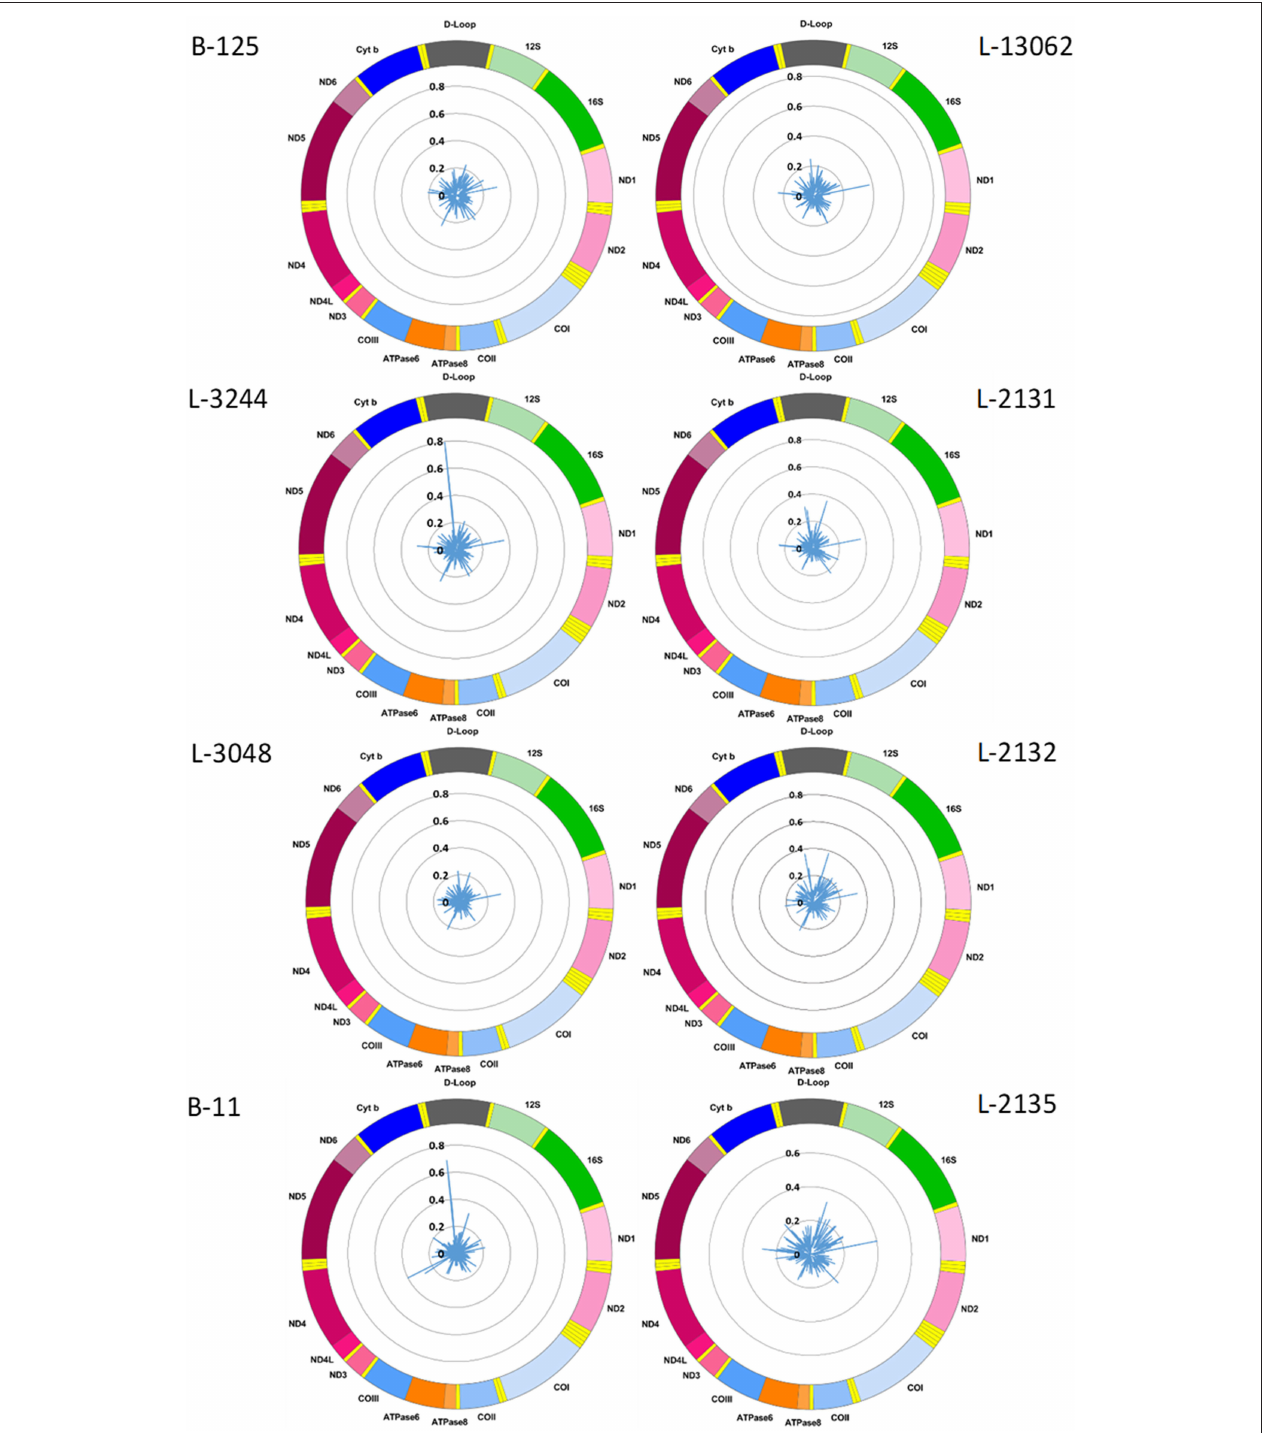
FIGURE 1 | Mitochondrial CpG methylation frequency detected by Nanopore sequencing in eight individuals. Radar chart showing mitochondrial DNA methylation from eight blood-derived DNA samples detected by Nanopolish. Methylation frequency is indicated by blue spikes. 12S, small subunit rRNA; 16S, large subunit rRNA; ND1, NADH dehydrogenase, subunit 1; ND2, NADH dehydrogenase, subunit 2; COI, cytochrome c oxidase, subunit 1; COII, cytochrome c oxidase, subunit 2; ATPase8, ATP synthase, subunit 8; ATPase6, ATP synthase, subunit 6; COIII, cytochrome c oxidase, subunit 3; ND3, NADH dehydrogenase, subunit 3; ND4L, NADH dehydrogenase, subunit 4L; ND4, NADH dehydrogenase, subunit 4; ND5, NADH dehydrogenase, subunit 5; ND6, NADH dehydrogenase, subunit 6; Cyt b, cytochrome b; D-Loop, displacement loop.